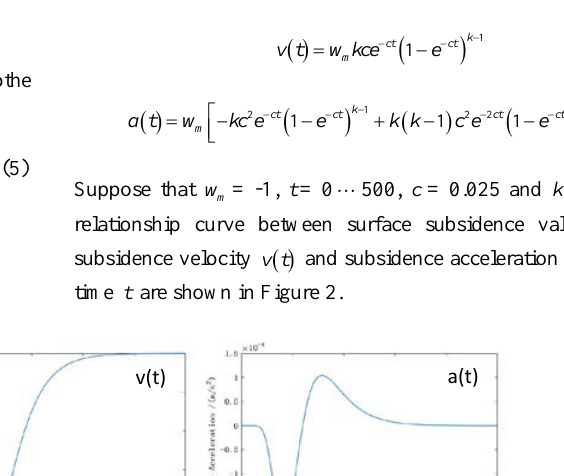
Figure 1. The surface subsidence, subsidence velocity and subsidence acceleration curve of Knothe model As shown in Figure 1, the subsidence velocity and acceleration at the initial moment are not zero, so the subsidence curve expressed by Knothe model is not agreement with the actual process of coal mining subsidence.